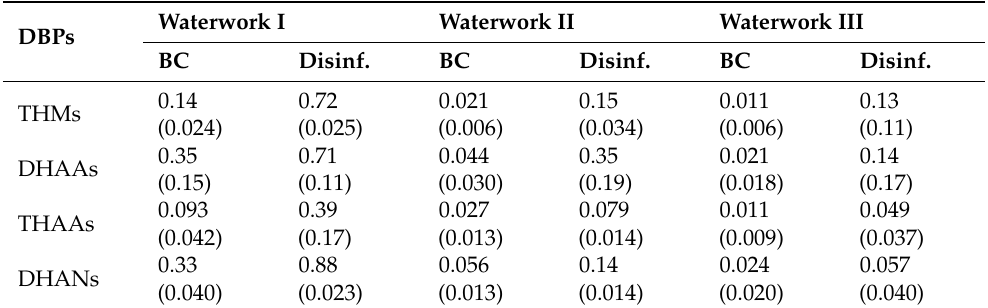
Table 3. Calculated BSF (with standard deviation) of DBP classes at different chlorination